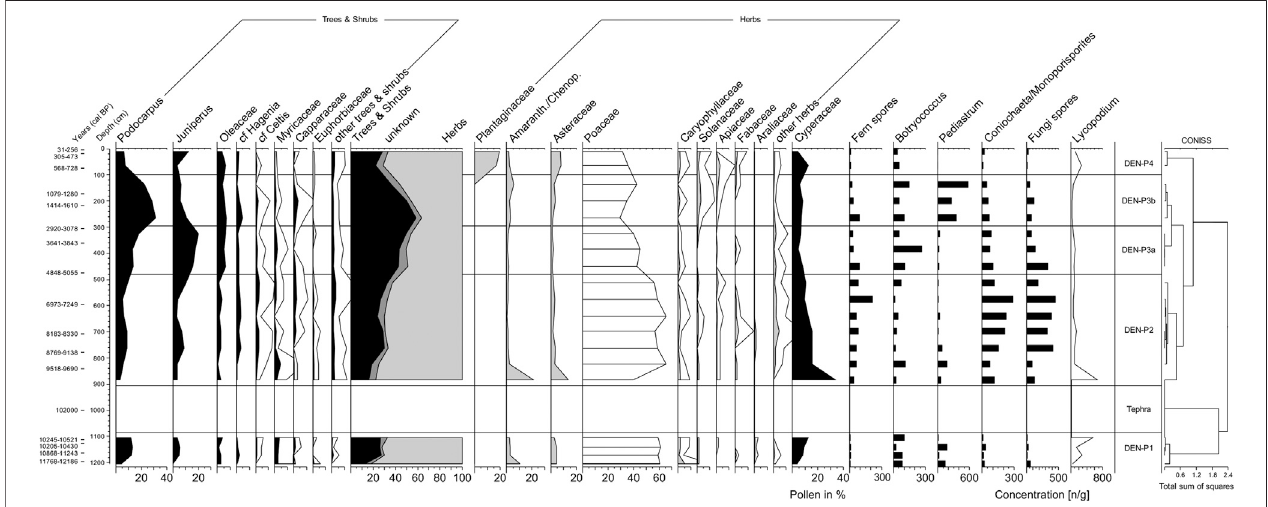
FIGURE 4 | Pollen diagram from Lake Dendi, showing percentage abundances of the principal taxa on a calibrated radiocarbon timescale. Percentages are calculated from the sum of all pollen grains (Cyperaceae excluded). The concentration of the palynomorphes was calculated based on the sediment dry weight.